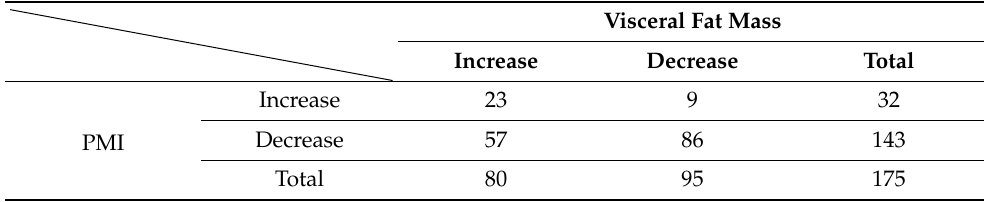
Table 2. Change in psoas muscle index (PMI) and visceral fat mass of 3% or more before and after neoadjuvant chemotherapy